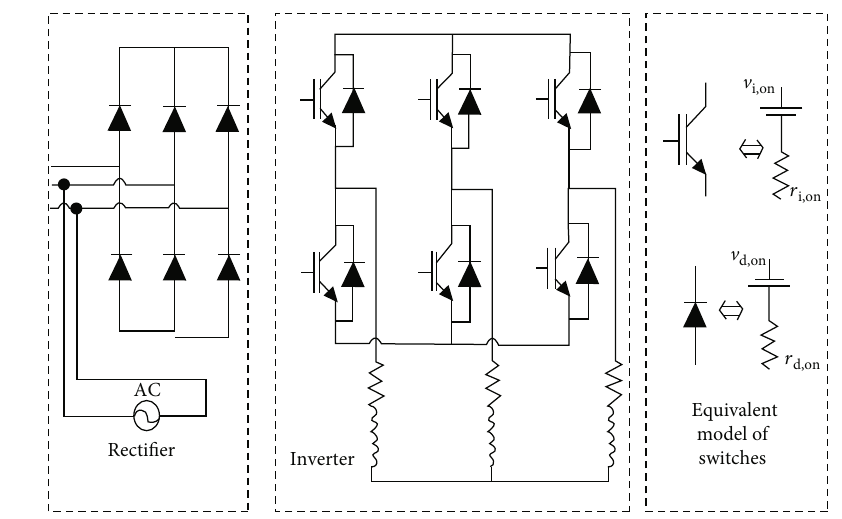
Figure 25: Model for AC/DC conversion